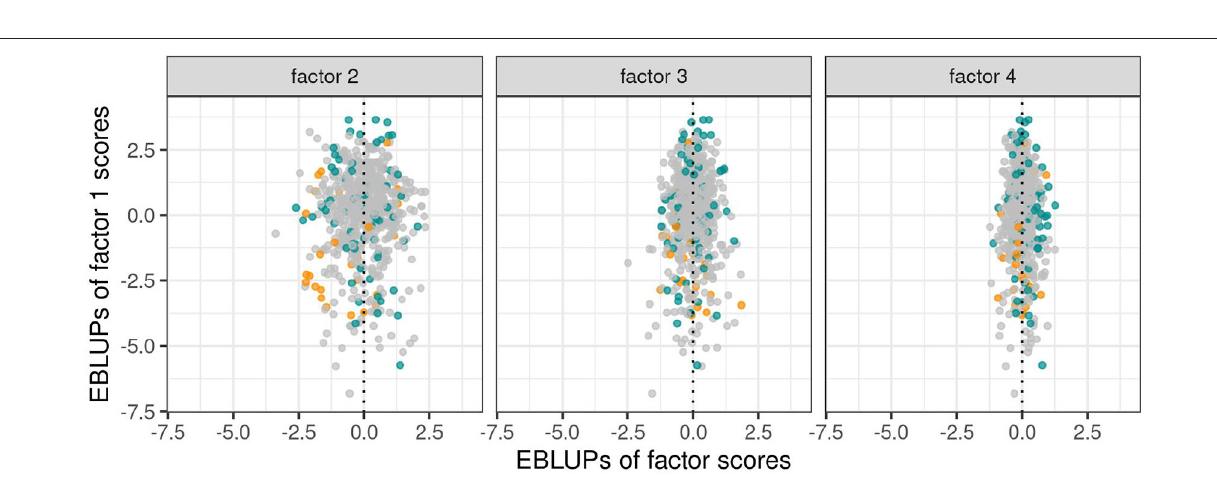
Figure 6 contains the two new varieties BALLISTA and STING, that were released as alternatives to the two